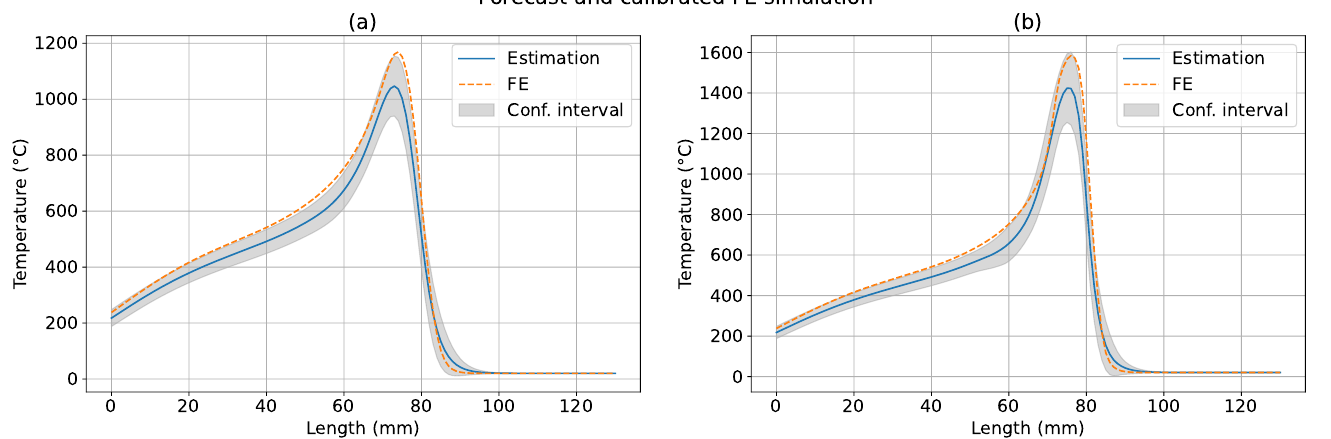
Figure 16. Forecasted temperature, FE simulation and confidence interval. ( a ) Camera side. ( b ) Torch side.